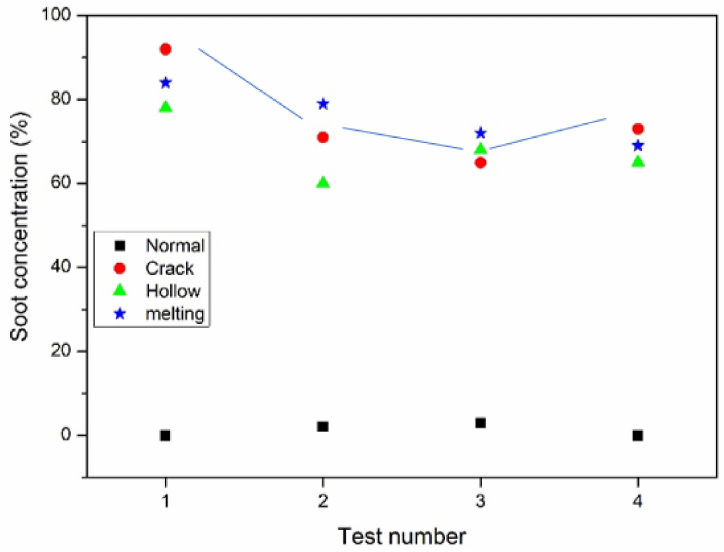
Figure 12. Smoke concentration with each with various DPF